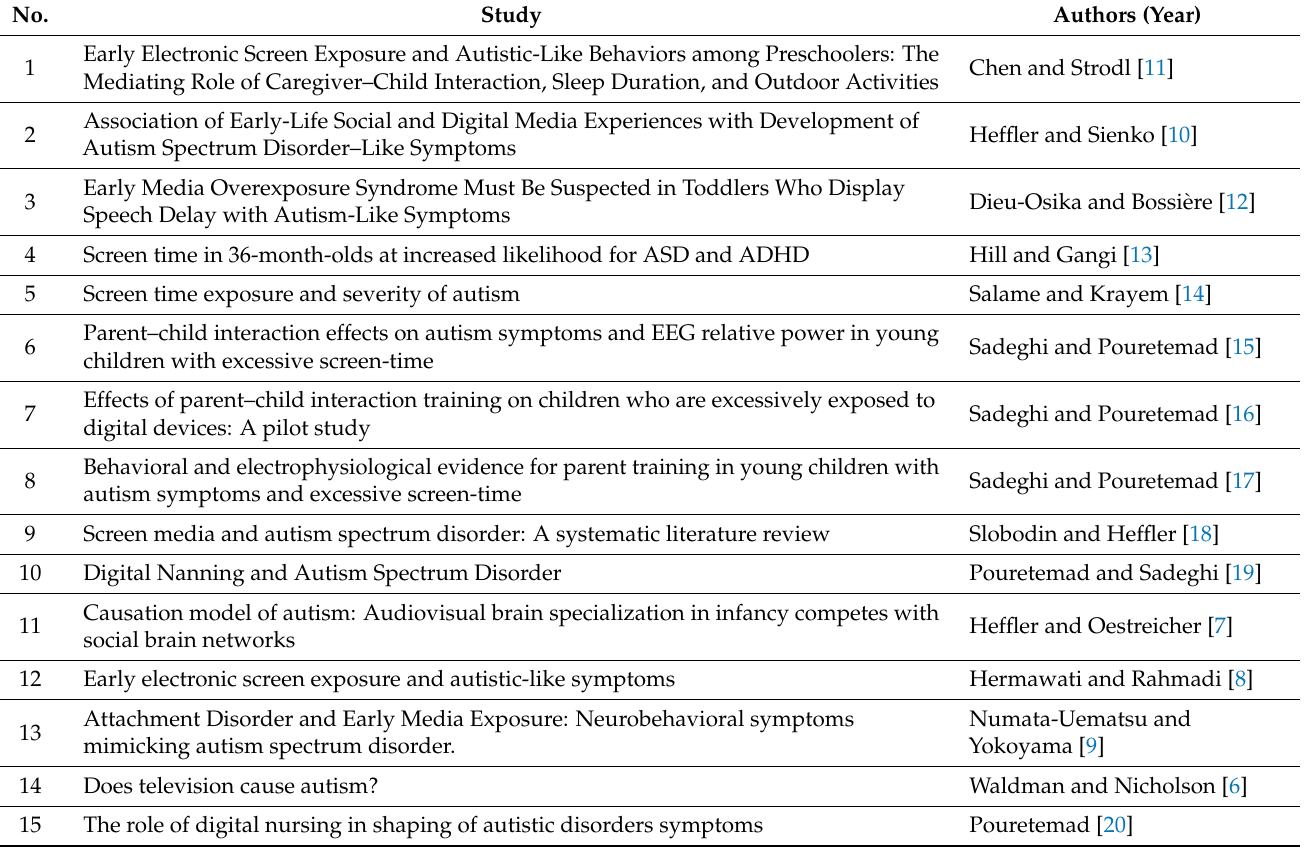
Table 1. Studies of the relationship between digital device exposure and